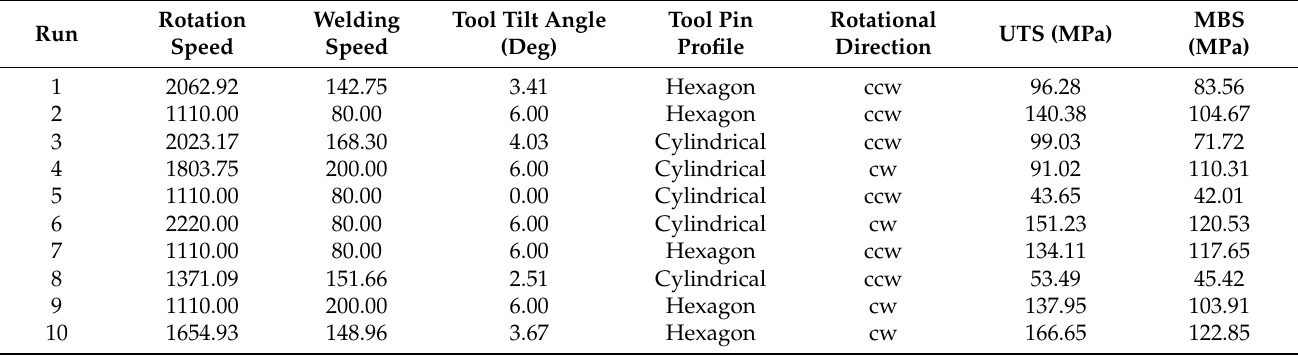
Figure 2. UTS and MBS test machine. Table 7. Actual design of experiments.